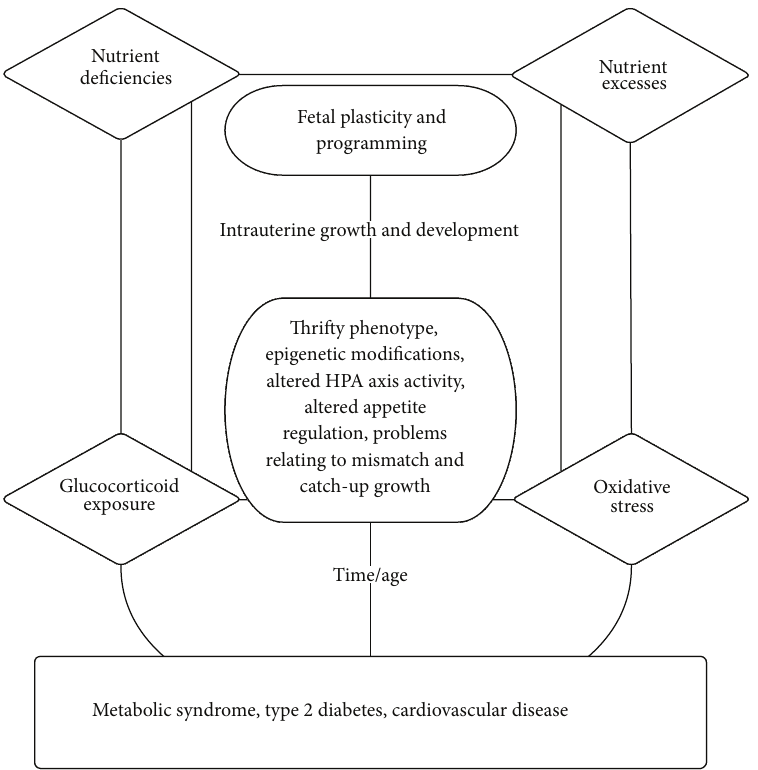
Figure 1: Schematic representation of the relationship between nutrient exposures and the concepts and mechanisms underlying the developmental origins of health and disease